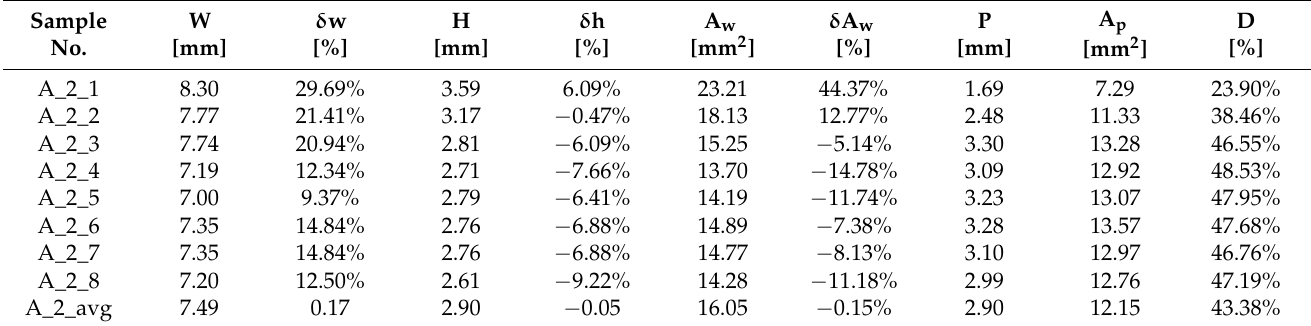
Table A2. Measurements of dimensional features of 2nd parameter set of Wire A—wire feed